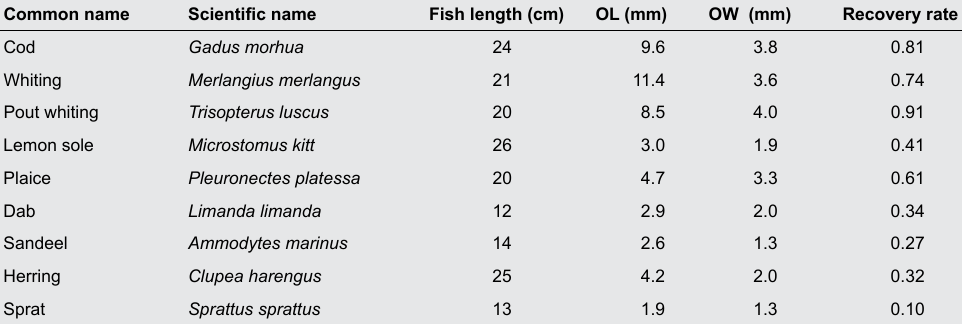
Table 2. Average species length and recovery rates from Bowen (2000). Otolith length (OL) and width (OW) calculated from fish length (Leopold et al. 2001).